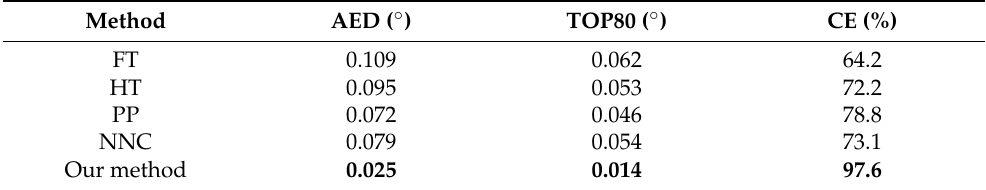
Table 4. Comparison results for the methods Fourier transform (HT), Hough transform (HT), Pro- jection profile analysis (PP), Nearest-neighbor clustering (NNC), and our method for using the PubLayNet dataset.